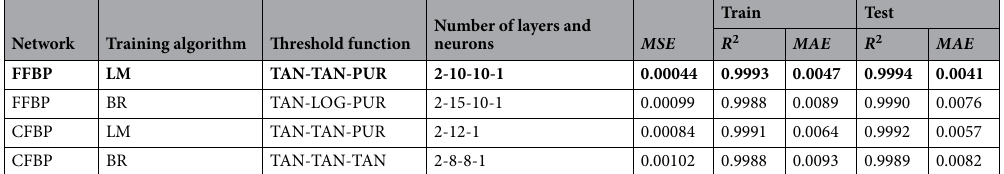
Table 5. The best values of evaluation criteria for FFBF and CFBF networks in different conditions of the number of layers and threshold functions for MR in CD dryer. The best values of the evaluation criteria are shown in bold